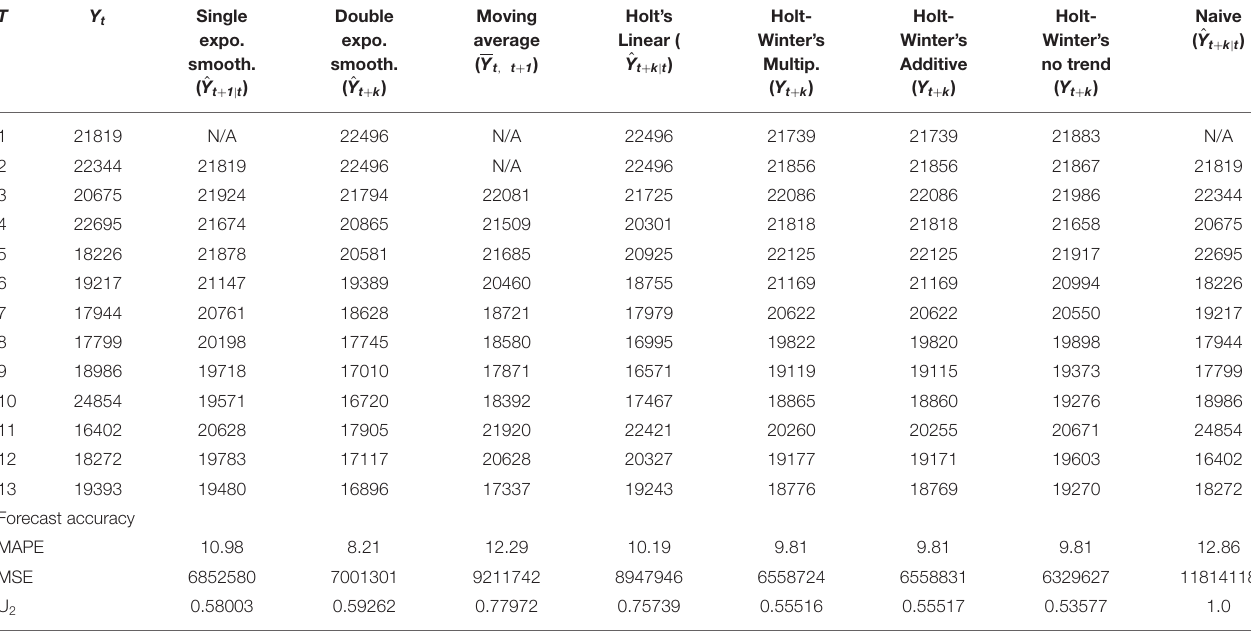
TABLE 4 | The results of forecasting (first approach and product without shortage).